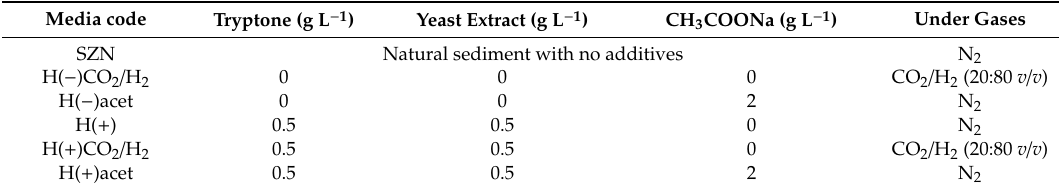
Table 5. Variants of the